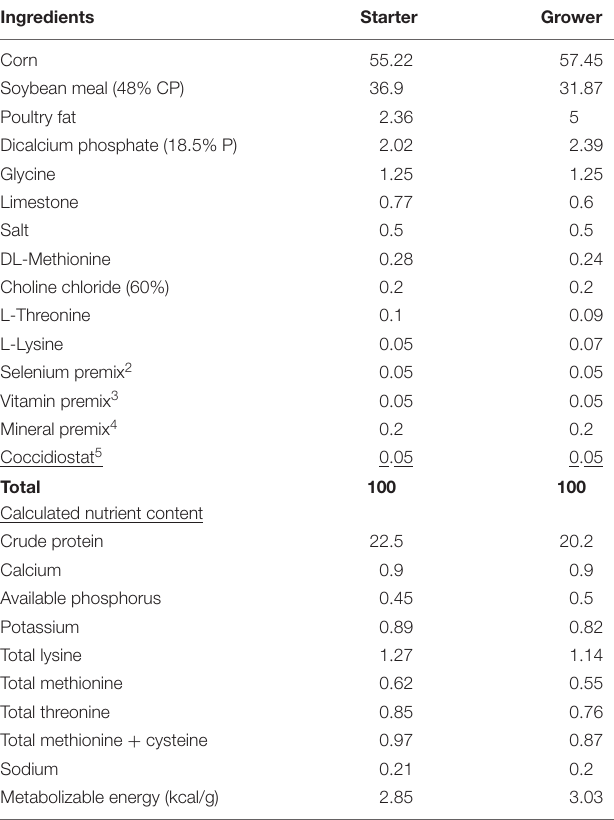
TABLE 1 | Composition of basal starter and grower diets 1